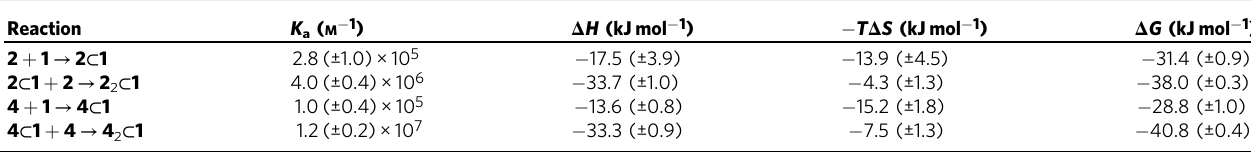
Table 1 Binding constants and thermodynamic parameters for the binding of cage 1 to guests 2 and 4, derived from ITC